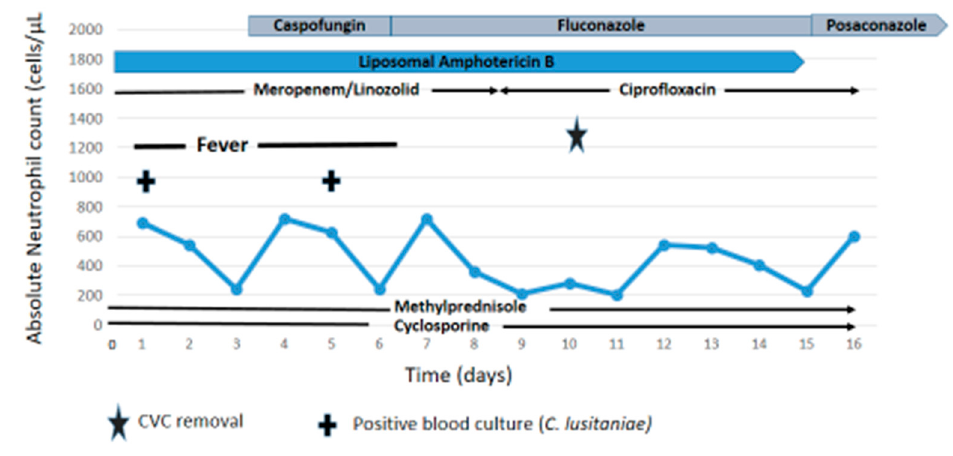
Figure 1. Time course of Candida lusitaniae fungemia and antifungal management.